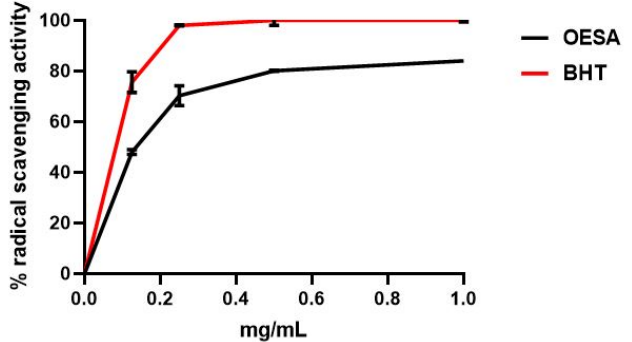
Figure 1. Percentage of radical scavenging capacity for OESA. Aliquots of various concentrations of OESA extracts (0, 0.125, 0.25, 0.5, 1 mg/mL) and standard BHT were mixed with DPPH and incubated in the dark. The antioxidant activity of OESA was measured using a spectrophotometer at 517 nm. Results were expressed as mean inhibition percentage (%) ± standard deviations (n = 3). BHT was used as the reference standard.